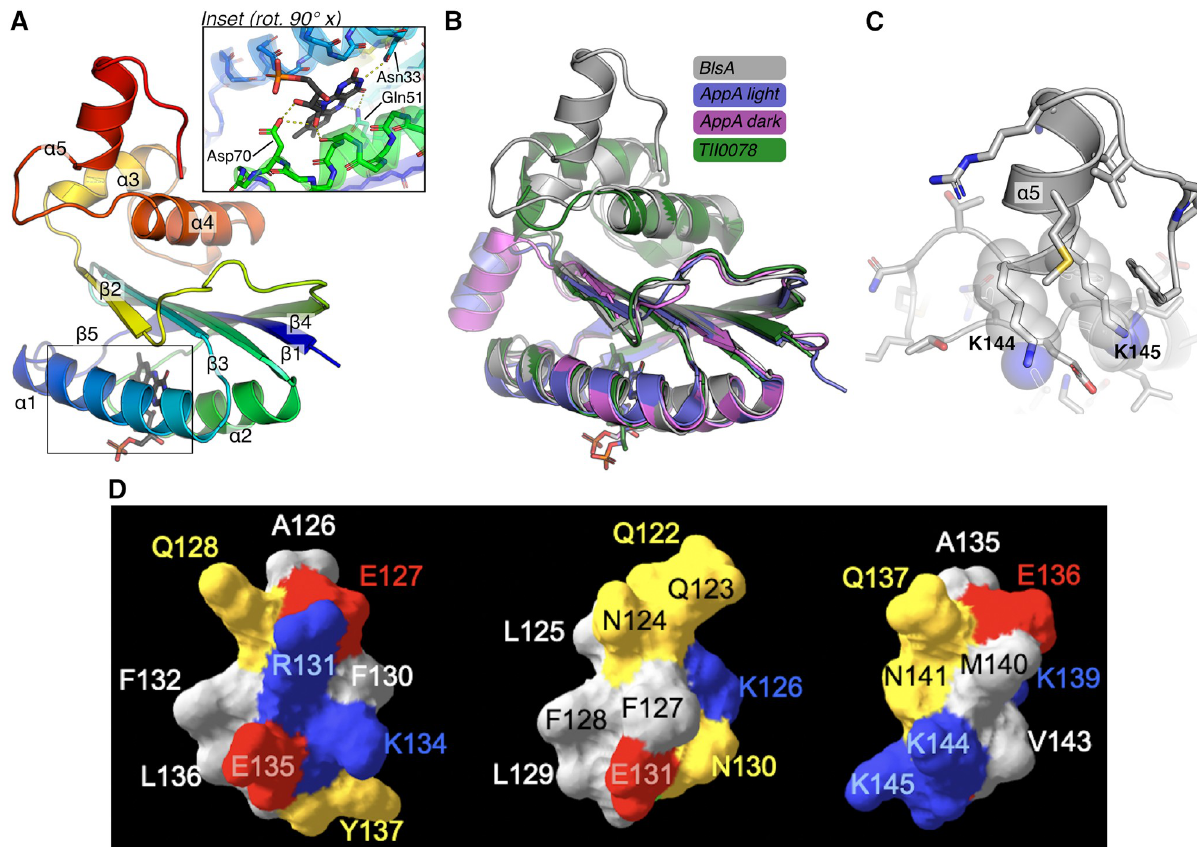
Fig 2. Structural model of BlsA and comparison to known blue light sensing domains. (A) Model of BlsA built using Robetta. BlsA is drawn as a cartoon colored by spectrum from the N-terminus (blue) to C-terminus (red) with secondary structure elements labeled and FAD drawn as sticks. The zoomed inset (rotated ~90˚ about the x -axis) shows BlsA residues (sticks) N33, Q51 and D70 making electrostatic contacts (yellow dashes) with FAD. (B) The BlsA model is superimposed with the structure of the AppA BLUF domain in the light- (blue, PDB ID 1yrx) and dark- (purple, PDB ID 2iyg) adapted states and Tll0078 (green, PDB ID 1x0p). (C) A zoomed view of BlsA helix α 5 from the Robetta model highlights the positions of K144 and K145. (D) Surface model of the Tll0078 α 4 (left) compared with surface models of two predicted BlsA CT α helices (middle and right) drawn using Modeller9v8. Yellow (polar), red (negative), blue (positive), grey (nonpolar). Visible residues are labeled according to their position in the amino acid sequence of the cognate proteins.